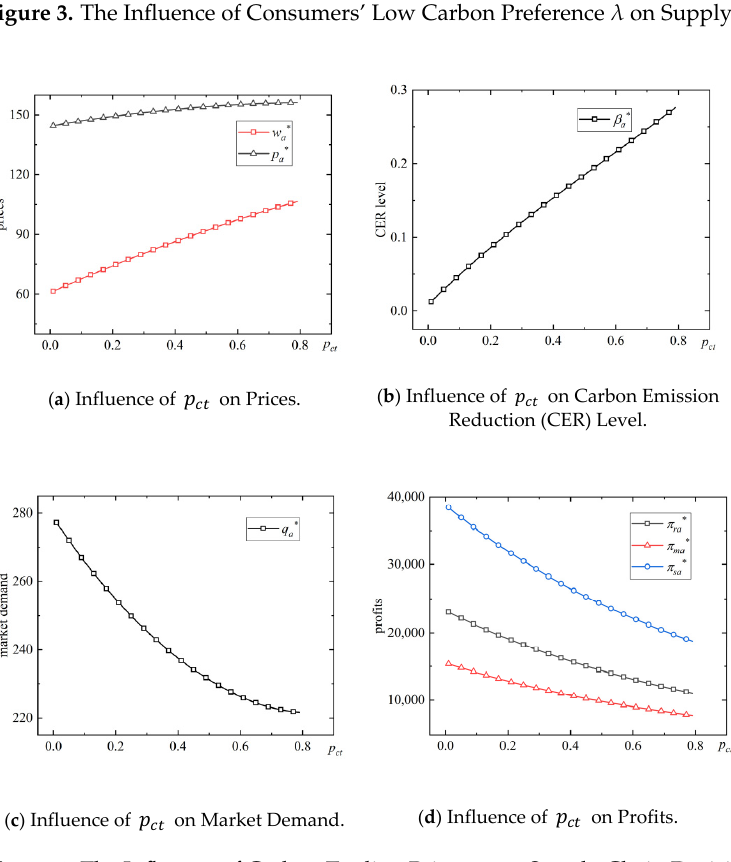
Figure 4. The Influence of Carbon Trading Price 𝑝 (cid:3030)(cid:3047) on Supply Chain Decision.